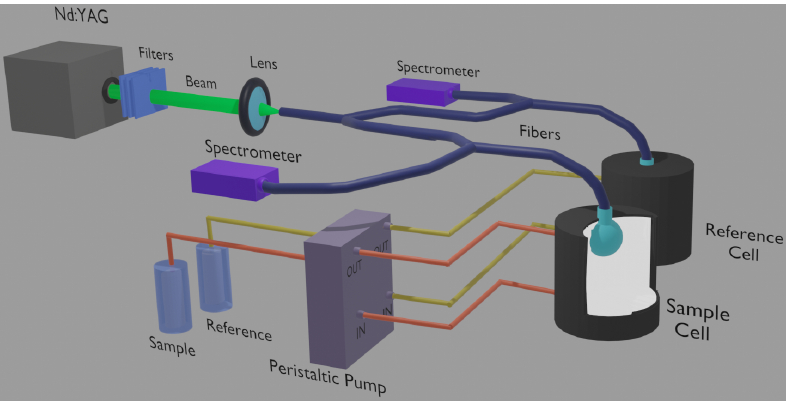
Figure 2. Scheme of the experimental setup. The sample cell is sectioned to allow seeing the sensor and the liquid sample